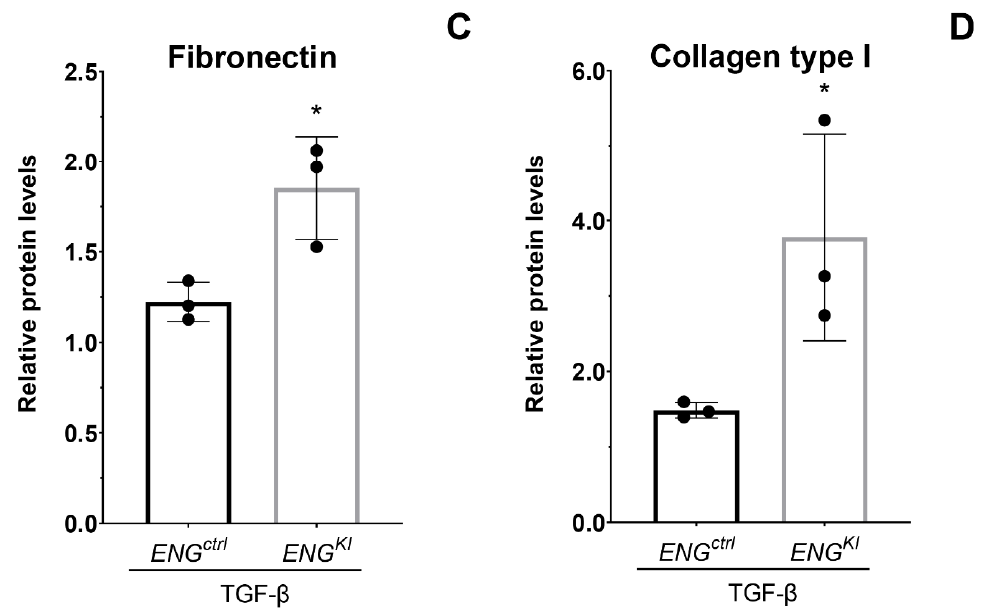
Figure 5. ENG K I fibroblasts have an increased TGF- β —induced production of fibronectin and collagen type I. ENG ctrl and ENG KI fibroblasts were incubated with (+) and without (-) 5 ng/mL TGF- β 1 for 24 h, after which a Western blot for collagen type I ( A ) and fibronectin ( B ) was executed. Relative upregulation of collagen type I ( C ) and fibronectin ( D ) protein levels upon TGF- β stimulation are displayed relative to their own unstimulated control. Protein levels were corrected for the loading control α -Tubulin. Summary data are presented as means ± SD from three independent experiments. * p < 0.05 (Student’s t -test after log transformation).